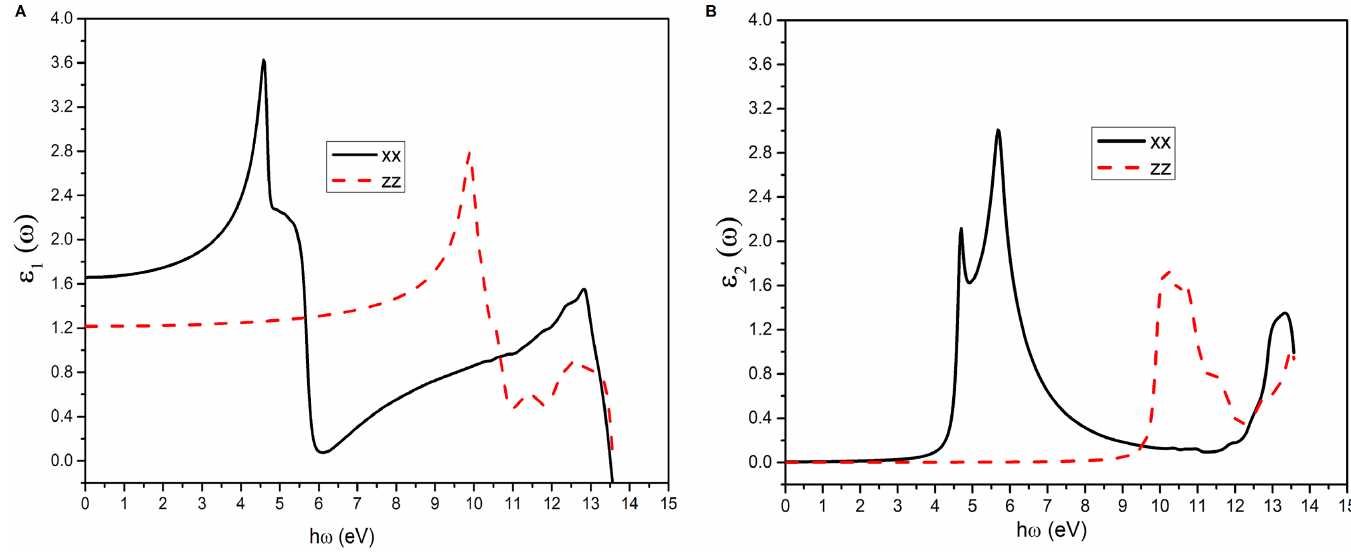
Figure 3 The dielectric function. (A) The real parts of the dielectric function in the xx and zz directions for ML h-BN. (B) The imaginary parts of the dielectric function in the xx and zz directions for ML